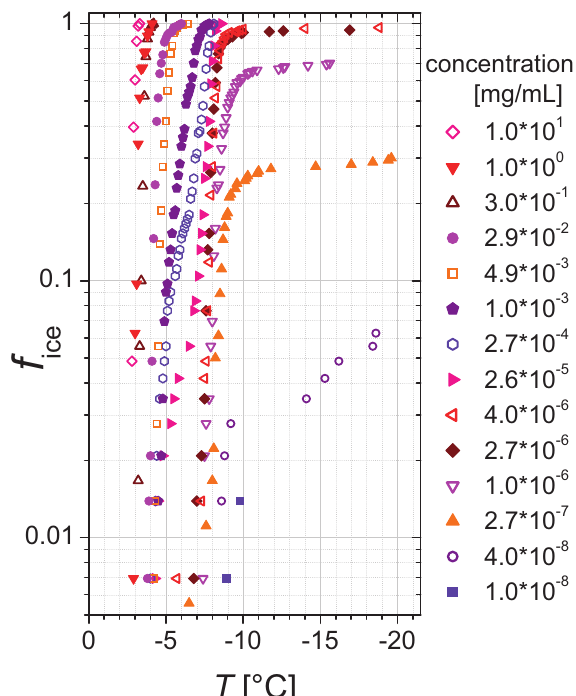
Figure 5. Frozen fractions as a function of temperature ( f ice ) as measured by BINARY for 14 differently concentrated Snomax sus- pensions for droplets with diameters of 1240µm (i.e., 1µL).